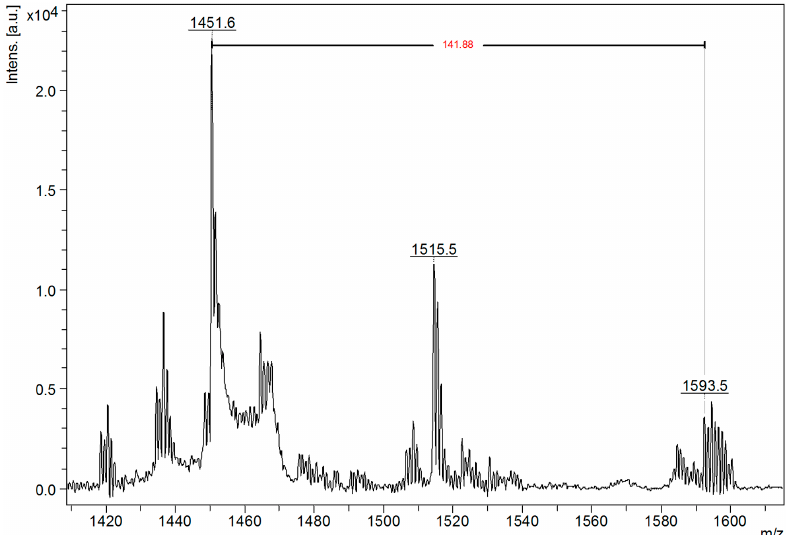
Figure 5. Positive-ion reflectron MALDI-TOF MS spectrum of the EDOT ∙ TMe- β CD.